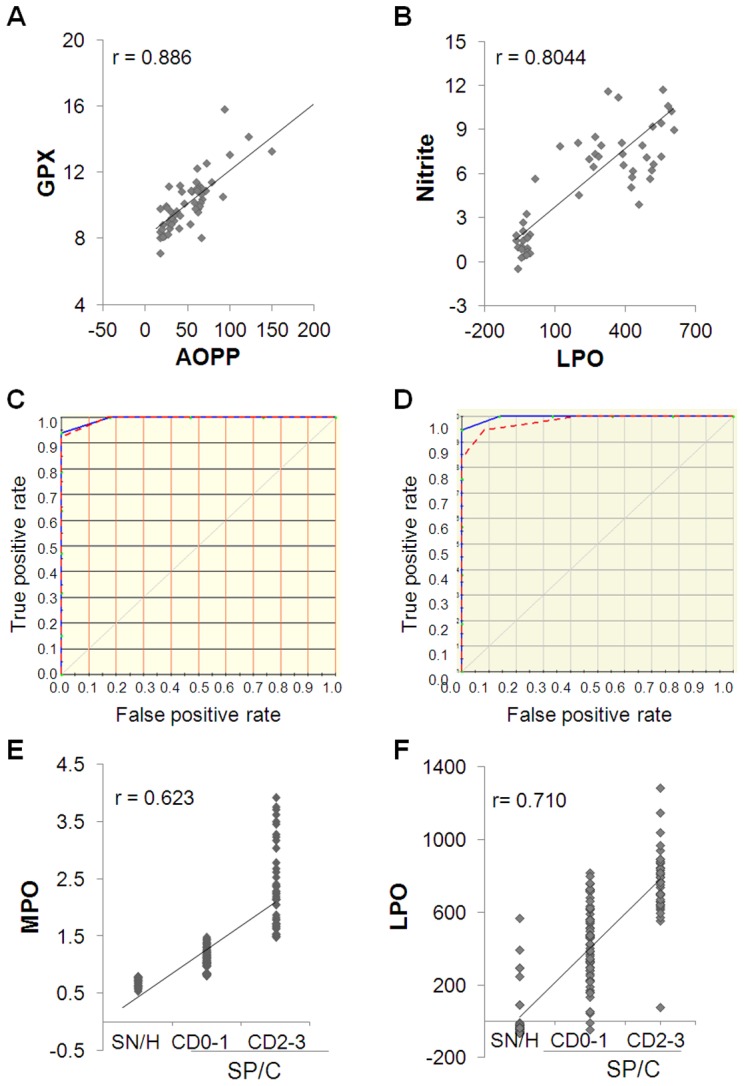
Pair-wise correlation and modeling analysis.Pair-wise correlation analysis of (A) nitrite (µmol/mg protein) with LPO (µmol/ml) and (B) glutathione peroxidase (units/mg protein) with AOPP (µmol/ml) utilizing data from plasma analysis of seropositive/chagasic and seronegative/healthy subjects is shown. (C&D) MARS analysis was performed using 80% of the data for various biomarkers from seronegative/healthy and seropositive/chagasic subjects as training dataset (blue curve) and 20% of the remaining data as test dataset to assess the performance of the model (red curve). Shown in panel C is MARS analysis of plasma levels of the biomarkers that revealed model fits perfectly (AUC/ROC = 1) on the training data for LPO, nitrite and SOD (with AUC/ROC of 0.099955 with testing dataset). Shown in panel D is MARS analysis of sera levels of the biomarkers that revealed model fits perfectly (AUC/ROC = 1) on the training data for MPO, LPO, and nitrite (with AUC/ROC of 0.9589 with testing dataset). (E&F) Shown are pair-wise correlation analyses of MPO (E) and LPO (F) contents with clinical disease. Each dot represents an individual subject.